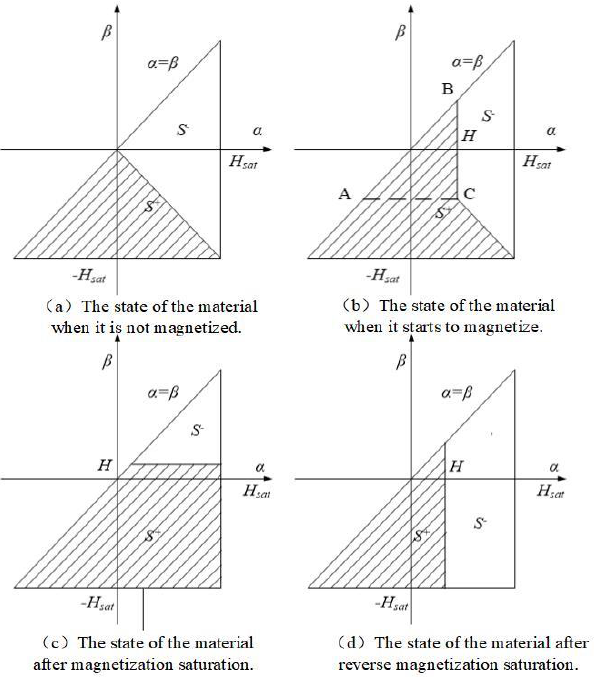
Figure 2. Preisach diagram under different states.